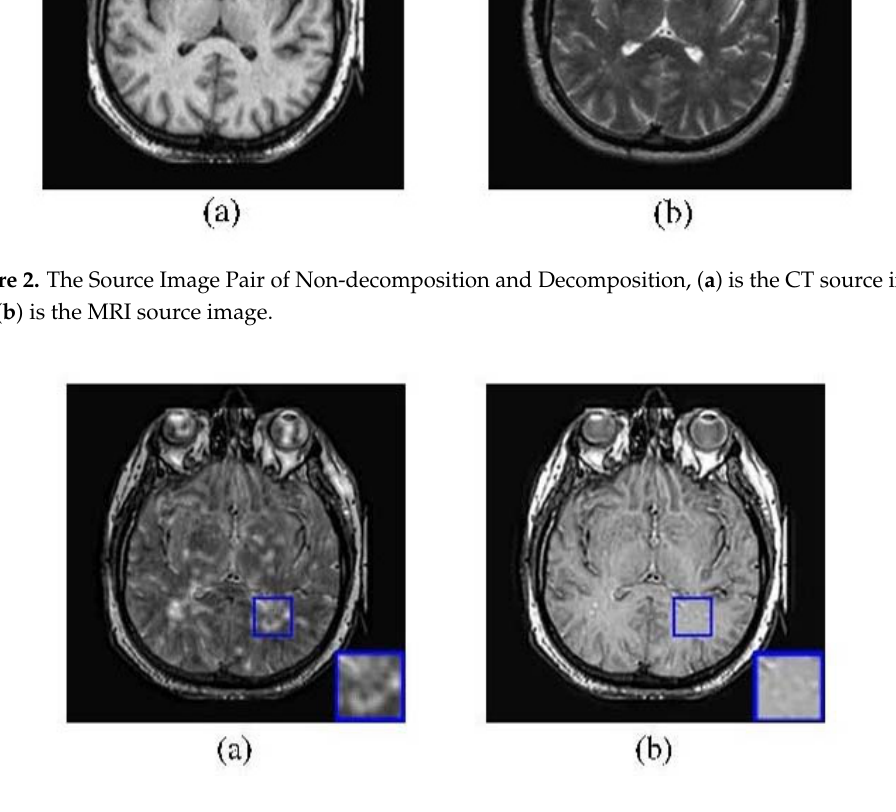
Figure 3. Detailed Comparison of Non-decomposition and Decomposition, ( a ) is the fused result of non-decomposition; and ( b ) is the fused result of